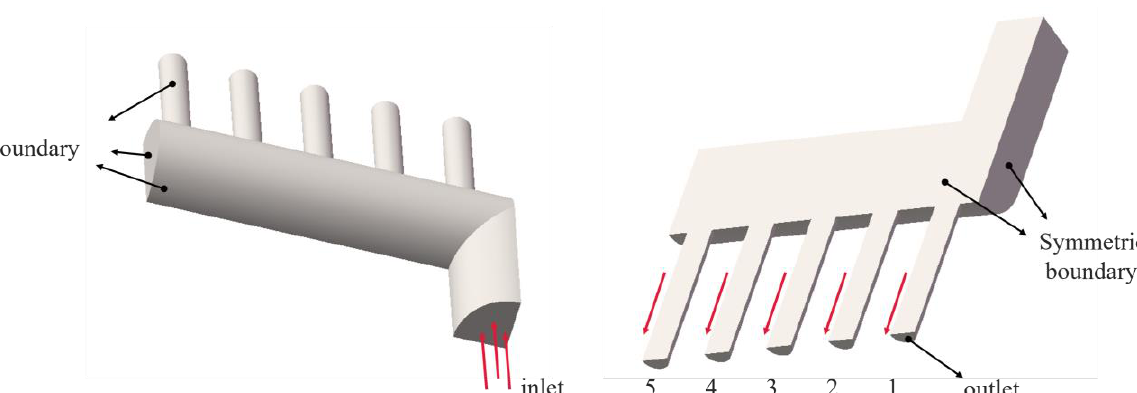
Figure 2. Physical models used for CFD and channel numbers.